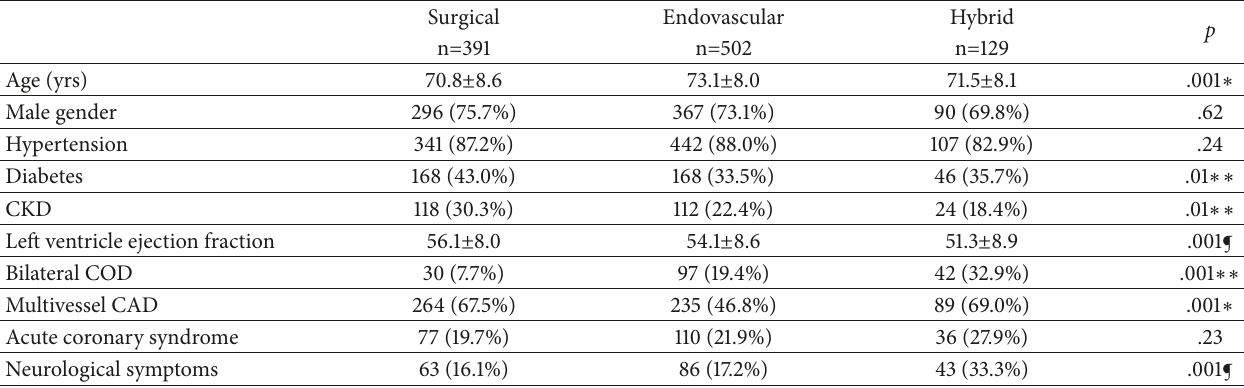
Table 2: Comparison of baseline clinical characteristics of the three groups.